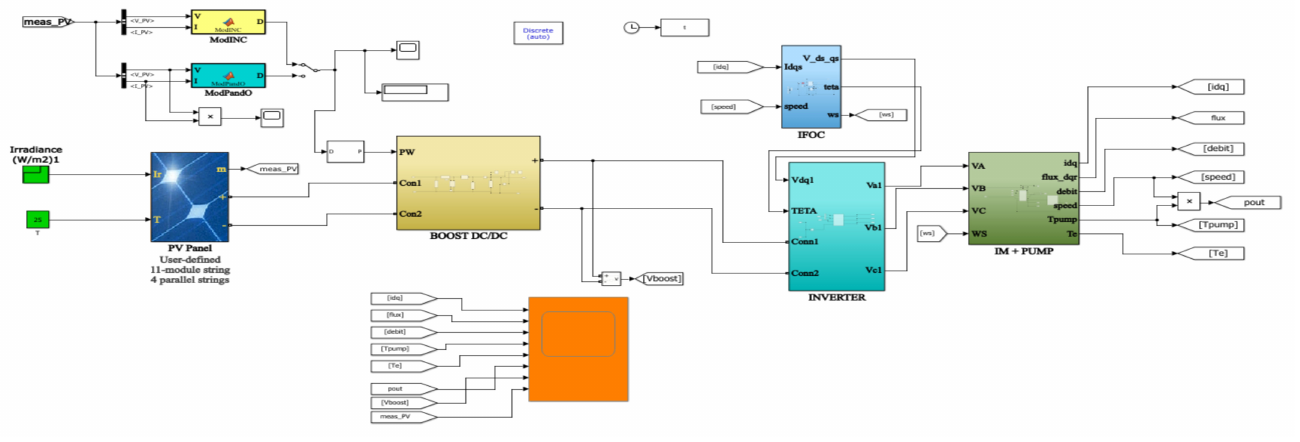
Figure 8. Solar pump simulation